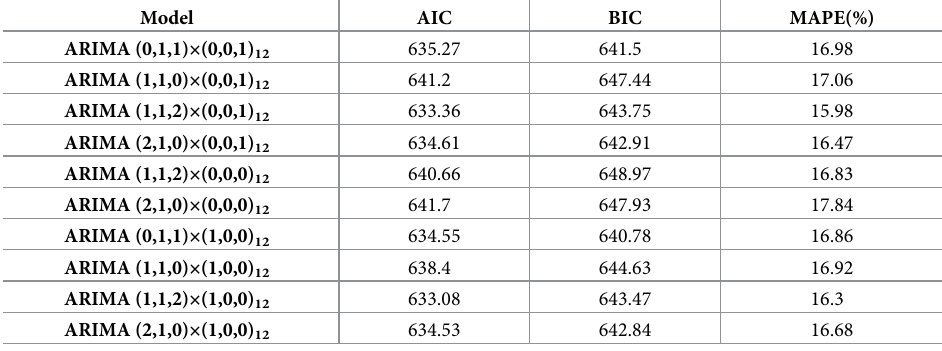
mal model with the minimum values of BIC = 643.75, MAPE = 15.98% in 10 candidate models Table 2. The evaluations of goodness-of-fit for plausible ARIMA